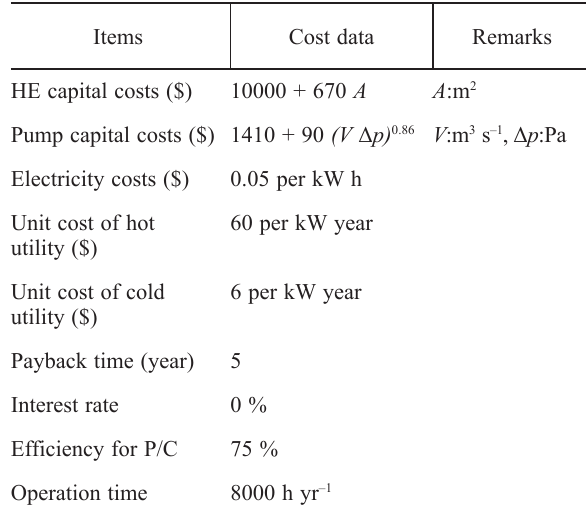
Table 2 – Physical properties for case study one Table 3 – Cost data for case study one